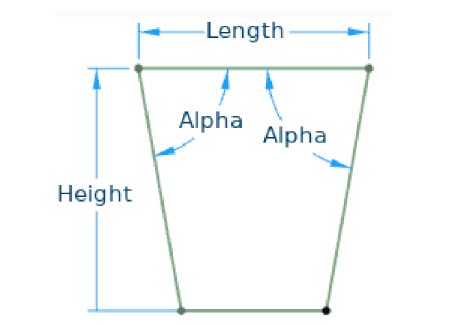
Figure 7. Model main dimensions.